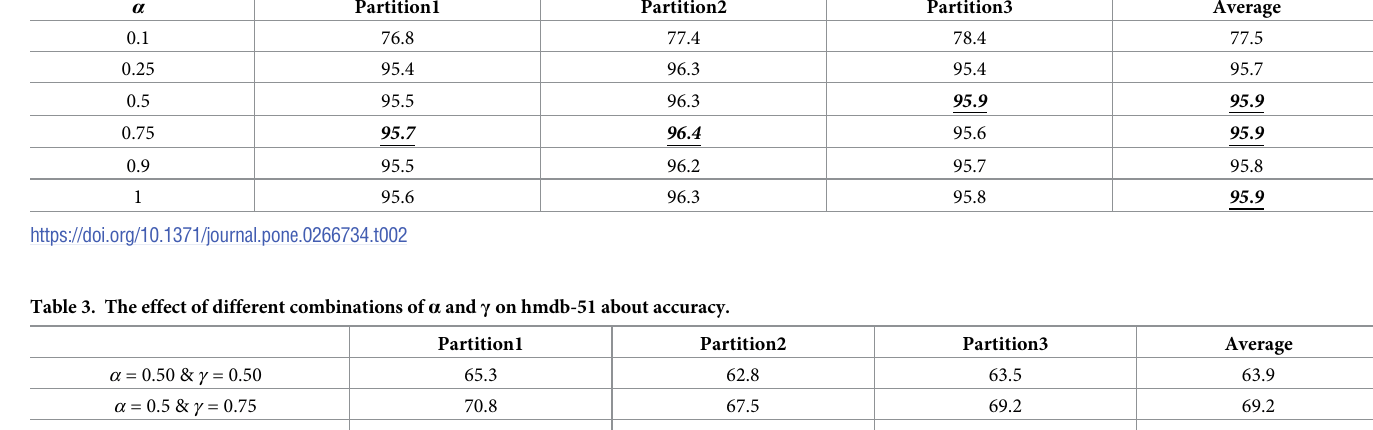
Table 2. The effect of different α and different partitions on ucf-101 about accuracy. α Partition1 Partition2 0.1 0.25